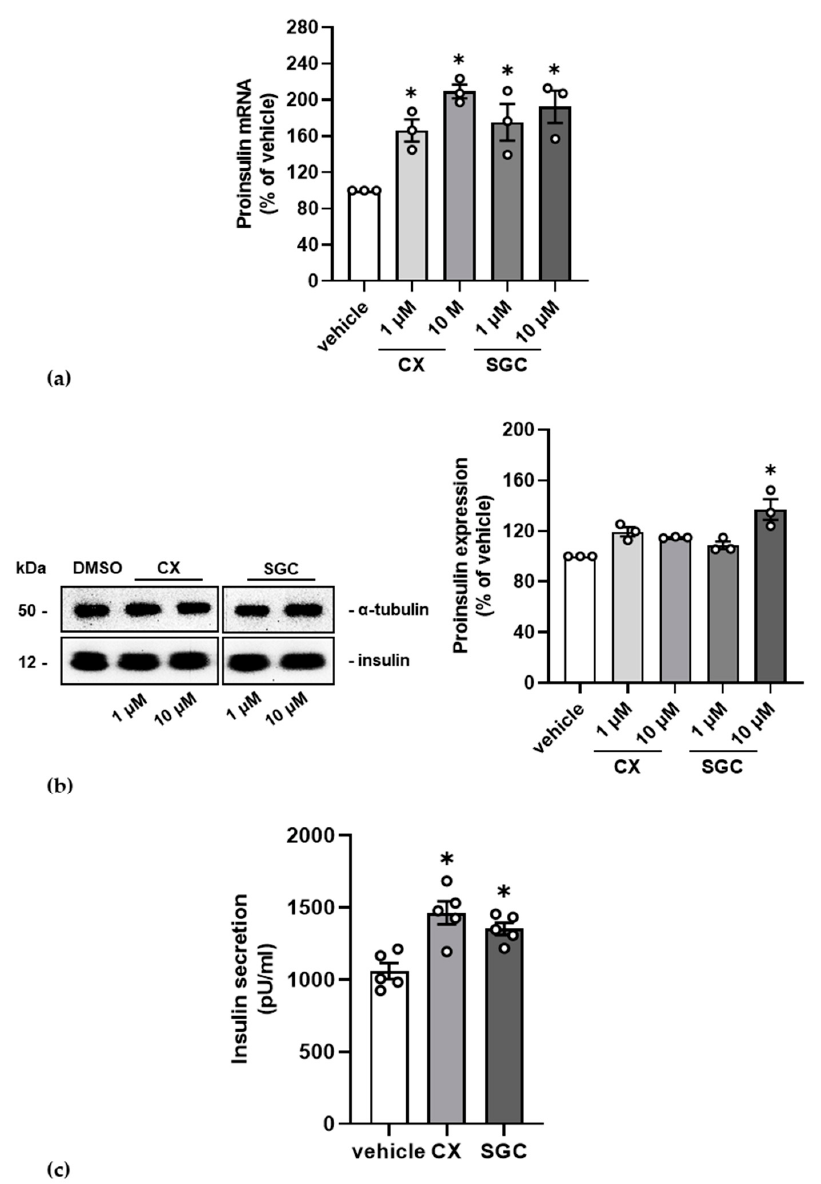
Figure 3. Influence of CK2 inhibition on insulin expression and secretion. MIN6 cells were treated with 1 or 10 µM SGC-CK2-1 (SGC) or 1 or 10 µM CX-4945 (CX) for 24 h. Control cells were incubated with an equal volume of the vehicle DMSO. ( a ) Cells were harvested, and total RNA was isolated using the QIAzol lysis reagent. The mRNA amount of insulin was determined using qRT-PCR. After normalization to GAPDH, the amount of insulin mRNA of control-treated cells was set 100% and the amount of treated mRNA cells calculated in reference to it. ( b ) Cells were harvested, proteins were extracted, and equal amounts were loaded on a 12.5% SDS polyacrylamide gel and blotted onto a PVDF membrane. A representative immunoblot analysis of MIN6 cell extracts for the detec- tion of proinsulin is shown; the detection of α -tubulin served as loading control. Signals for proin- sulin from three independent experiments were analyzed by a densitometric scan and normalized to the arbitrary amount of the loading control α -tubulin. The relative mean amount of proinsulin +/ − SD for the different treatments is shown as bar graphs. ( c ) After a glucose stimulus, secreted insulin was determined in the cell culture supernatant with the insulin ELISA kit. Statistical analysis in all experiments was performed as described in “Material and Methods”. * Statistical significance was accepted with a p-value of at least p < 0.05.